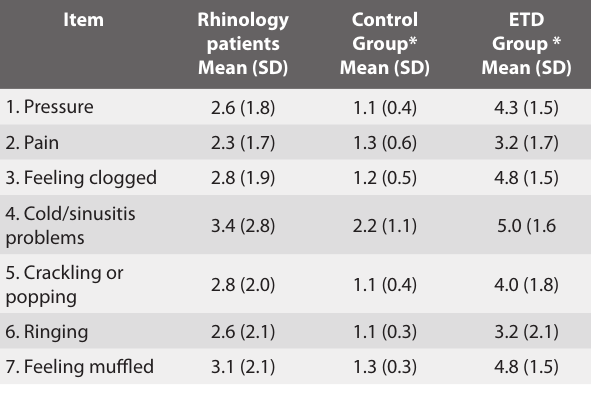
Table 2. Eustachian Tube Dysfunction Scores by Item. SD = standard deviation. * Literature values given by McCoul et al. (11) .